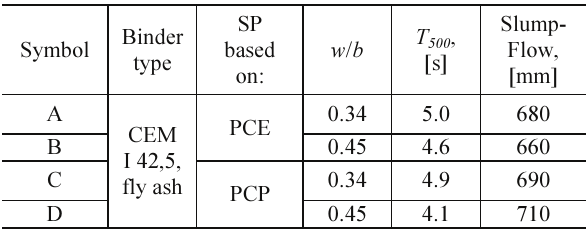
Table 4. Test results of rheological properties of concrete mix with the use of Abrams cone (Gorzelańczyk 2007)